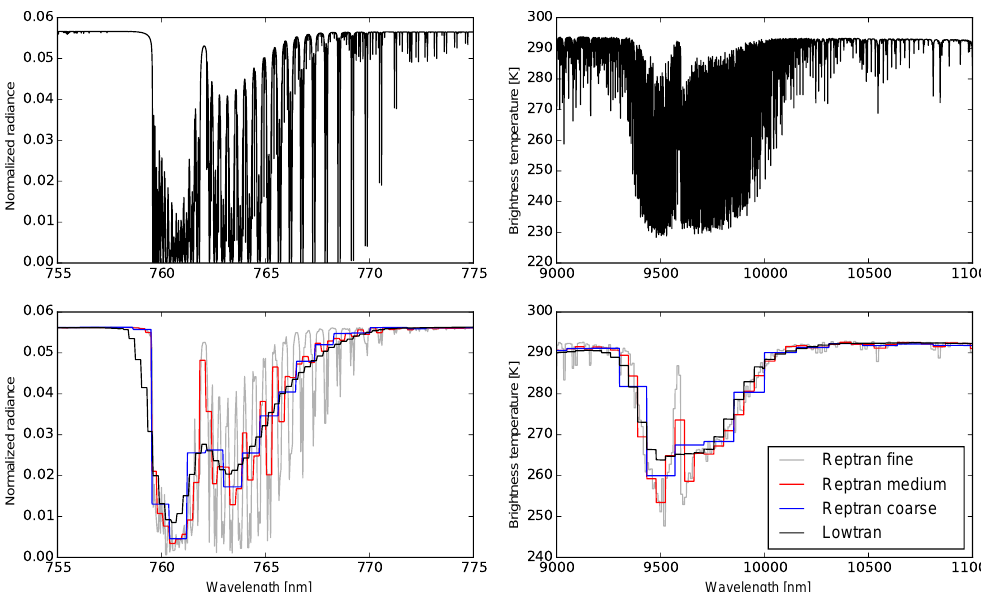
Figure 2. Nadir top-of-the-atmosphere radiance in the oxygen-A band around 760nm (left) and in the IR (infra-red) window region (right) for the midlatitude-summer atmosphere of Anderson et al. (1986). All calculations were performed with the MYSTIC solver using the “ab- sorption lines importance sampling” method (Emde et al., 2011). (Top) high spectral resolution calculation, based on line-by-line absorption cross sections calculated using ARTS (Eriksson et al., 2011); (bottom) pseudo-spectral calculations using the representative wavelengths band parameterizations ( reptran ) with different resolutions and lowtran . For comparison see also Fig. 3 in Mayer and Kylling (2005), which shows transmittances for genln2 line-by-line calculations and lowtran for the same spectral